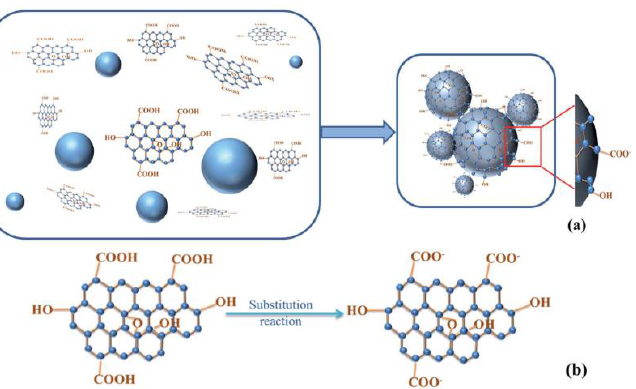
Figure 3. Chemical adsorption reaction schematic of GO on cement surface. ( a ) Adsorption of GO on the cement surface. ( b ) The substitution reaction of GO in the adsorption system. Reprinted with permission from Ref. [51]. Copyright 2016 RSC Publishing.